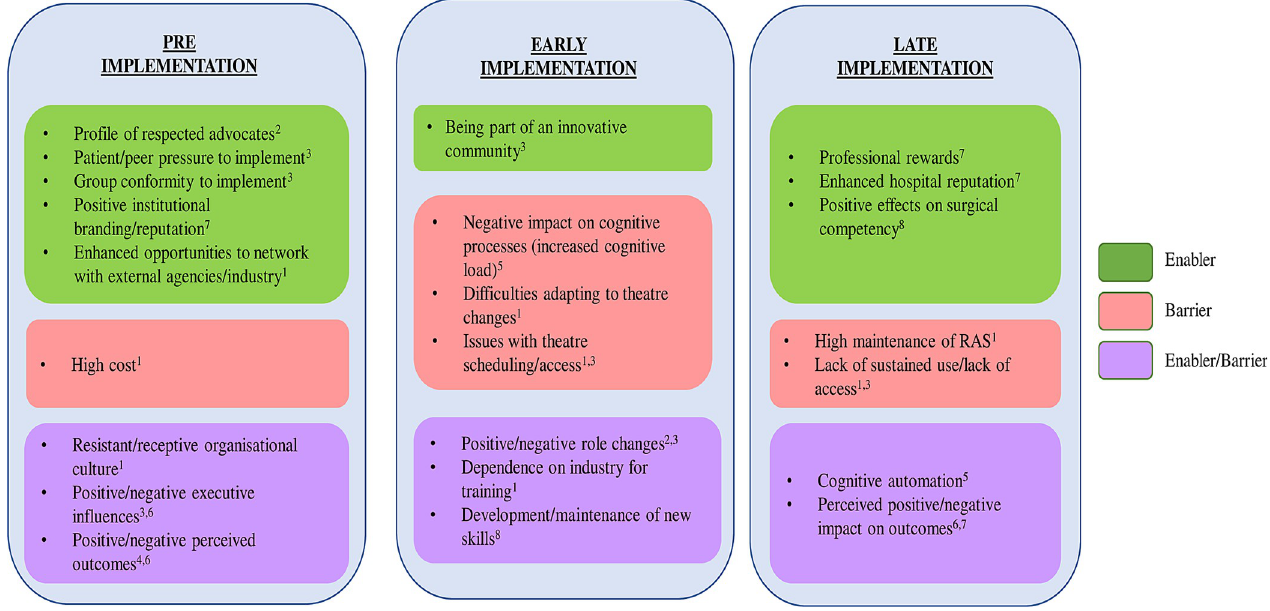
Fig 1. The barriers and enablers of implementation at each phase of adoption. TDF domains: 1 Environmental Context & Resources, 2 Social Professional Role & Identity, 3 Social Influences, 4 Beliefs about Consequences, 5 Memory Attention & Decision Processes, 6 Knowledge, 7 Reinforcement, 8 Skills.